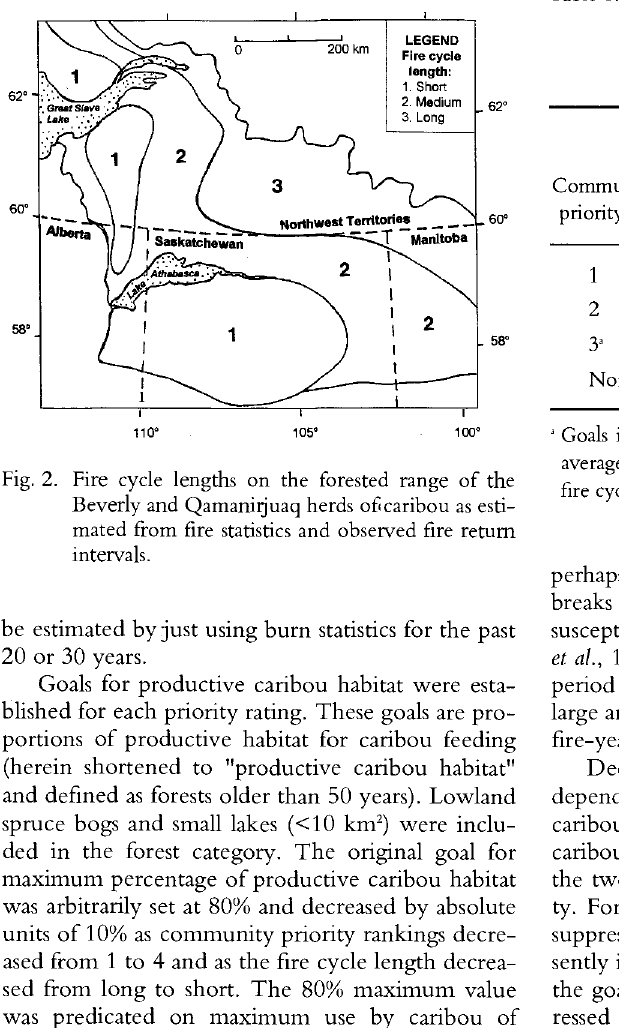
Table 1. Goals for the proportion of forest older than 50 years (productive caribou habitat) by communiti es' priority rank for caribou hunting and by length of the fire